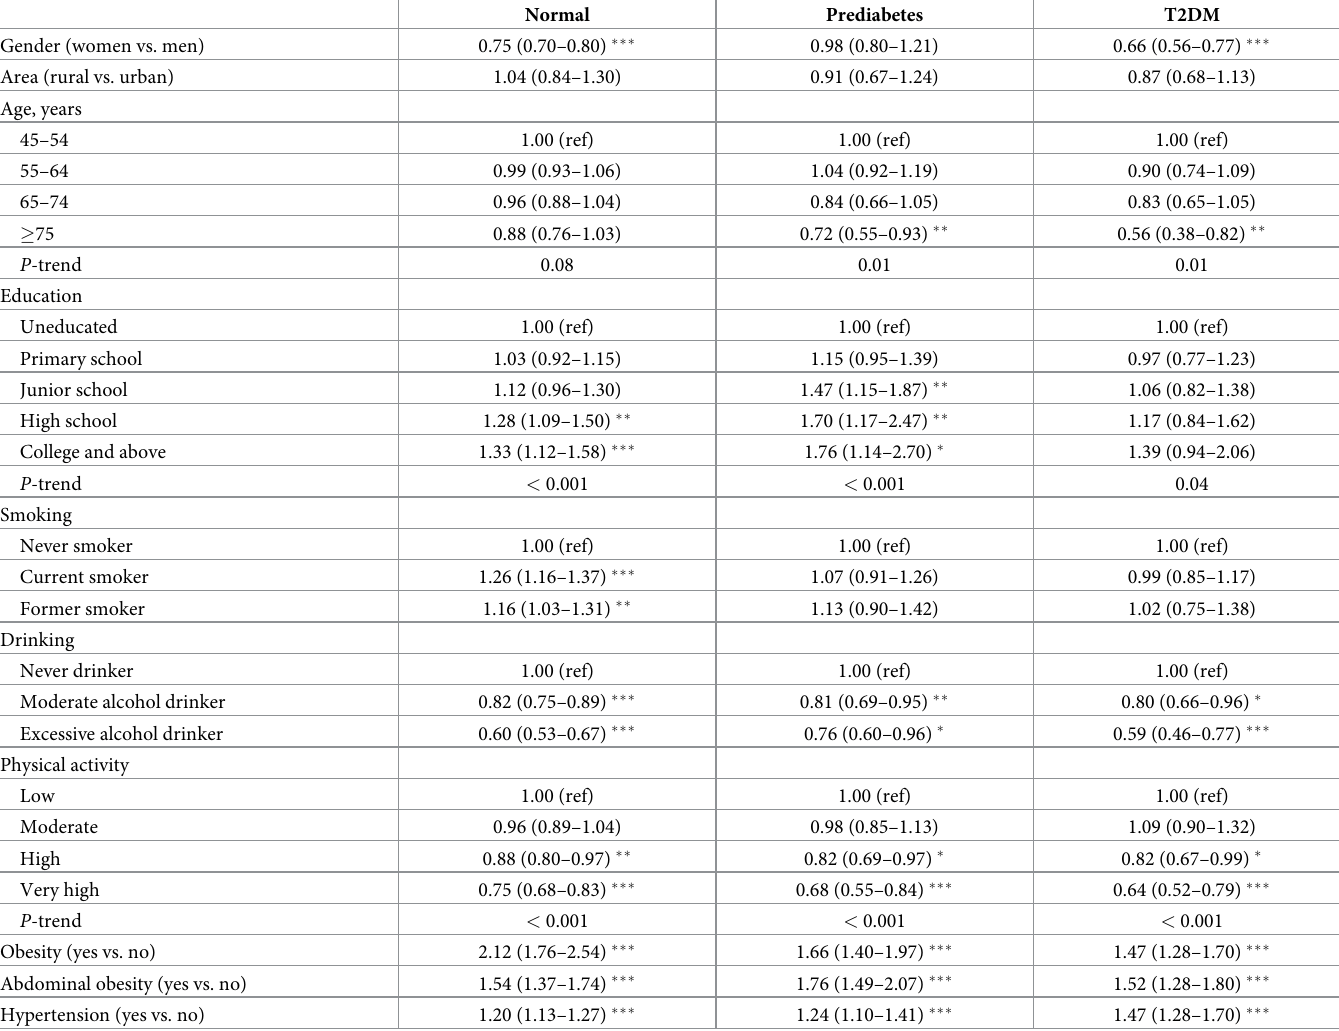
Table 3. The associated factors of dyslipidemia in different diabetic progression stages (69974).